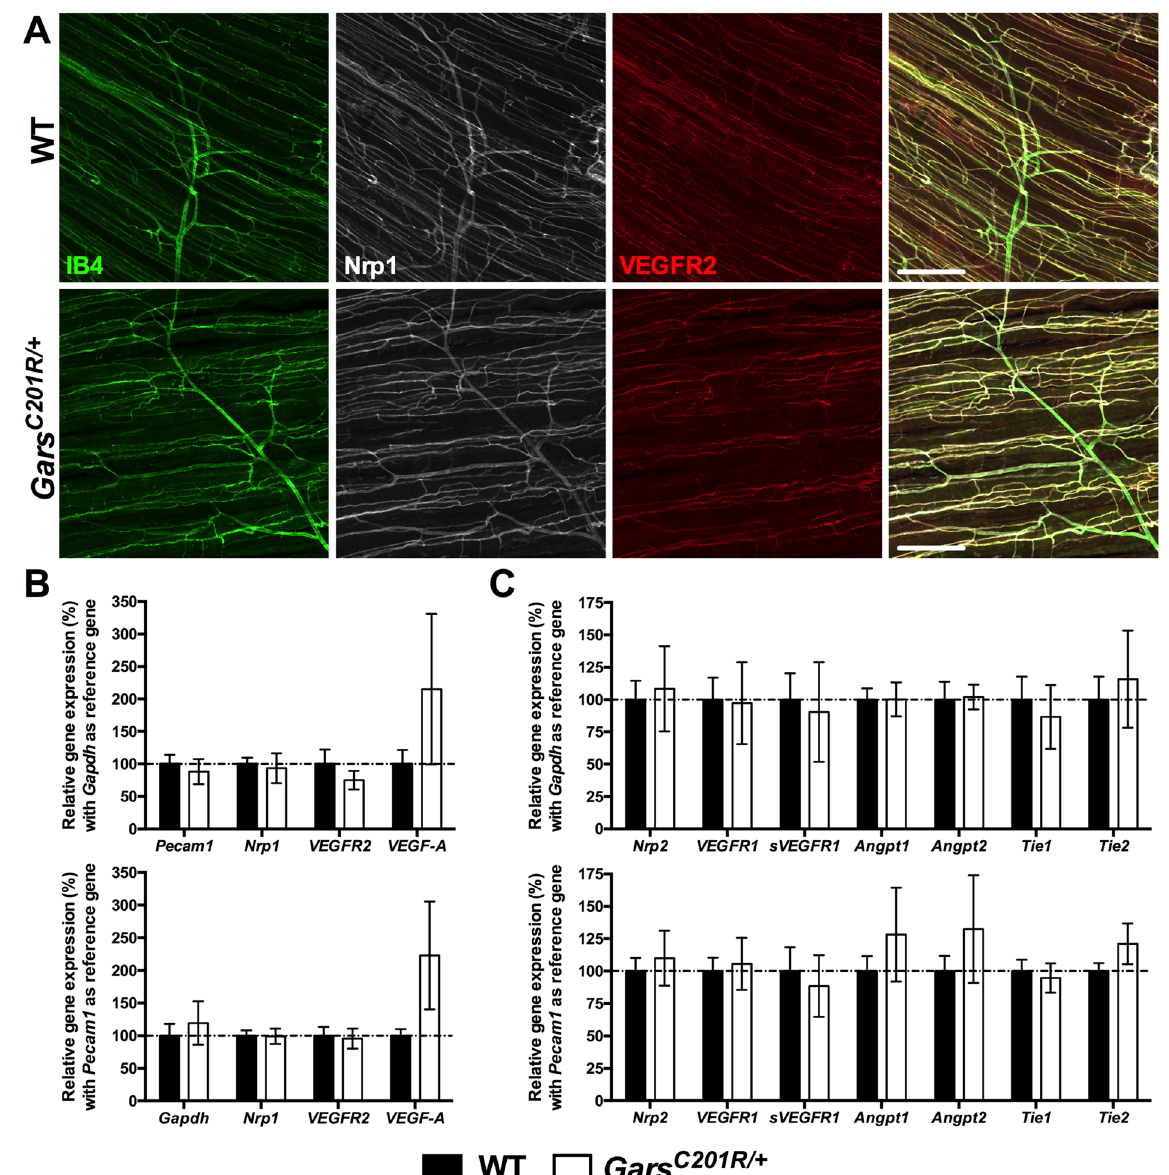
Figure 4. Pathways integral to vascular homeostasis appear unperturbed in mutant Gars muscle. ( A ) Representative Nrp1 (white) and VEGFR2 (red) staining in one month old wholemount wild-type and Gars C201R / + TVA muscles. Nrp1 and VEGFR2 colocalise with the endothelial marker IB4 (green) in both genotypes, and show no obvious differences. A similar pattern was seen at three months and in the lumbrical muscles at both time points (data not shown). Both panels are single plane images. Scale bars = 200 μ m. ( B,C ) qPCR analysis of a series of genes integral to the maintenance of blood vessels indicates very little perturbation in gene expression in one month Gars C201R / + tibialis anterior muscles. This was confirmed using either Gapdh (top graphs) or endothelium-specific Pecam1 (bottom graphs) as the reference gene. All individual gene data sets were separately analysed with unpaired, two-tailed t -tests. n = 6 wild-type and 4 Gars C201R / +